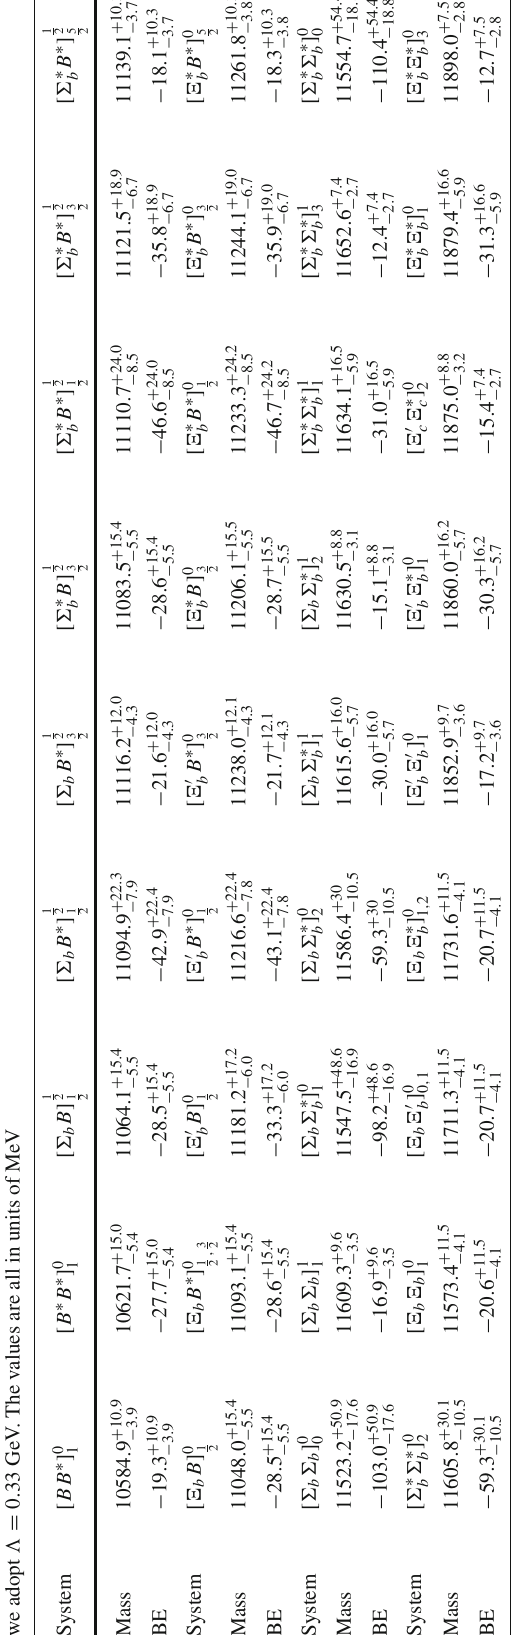
/ 2 , T (cid:3)− , [ (cid:3) b B ] 1 , bb bb 1 / 2